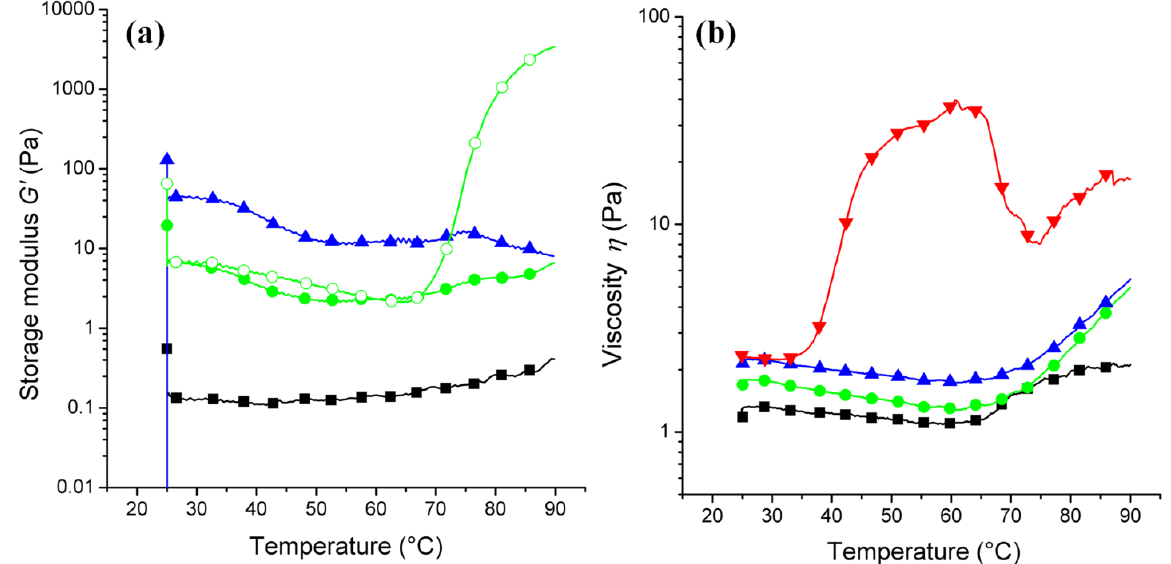
Figure 2. ( a ) Influence of the methylcellulose concentration and the temperature on the relative viscosity for the precursor solution mixed with 0% (Z0, black square), 3.5% (NZ040, green filled circles), 6.8% (NZ080, blue triangle up) and 3.5% (pure MC at pH = 11, green open circles) of methylcellulose, determined from oscillatory measurements at 1 Hz. ( b ) Gel formation determined from rotational measurements at 1 Hz: PSS (black squares), 3.5% (NZ04, green circles), 6.8% (NZ080, blue triangles up) and 3.5% (pure MC at pH = 11, upside-down red triangles) (samples with g/100 mL water or precursor